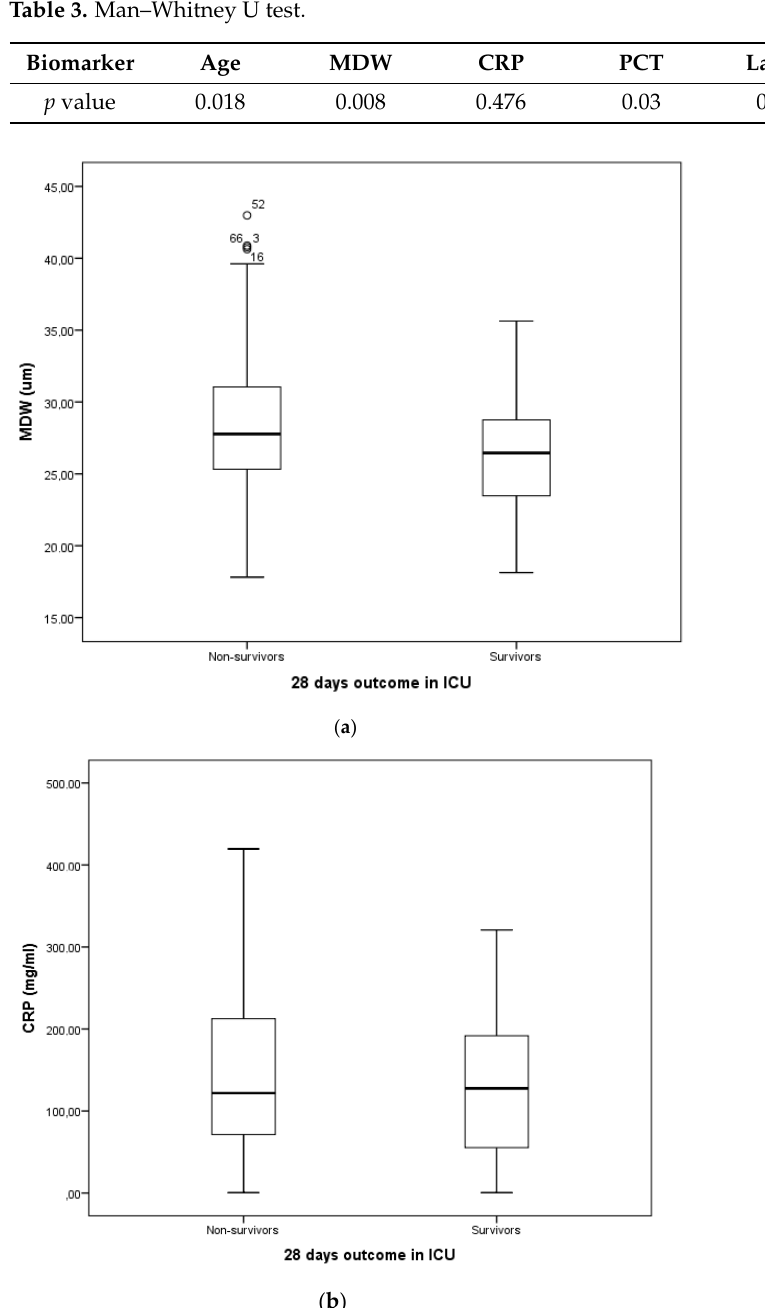
Table 2. Chi-square test for MDW, CRP, PCT, and lactate.